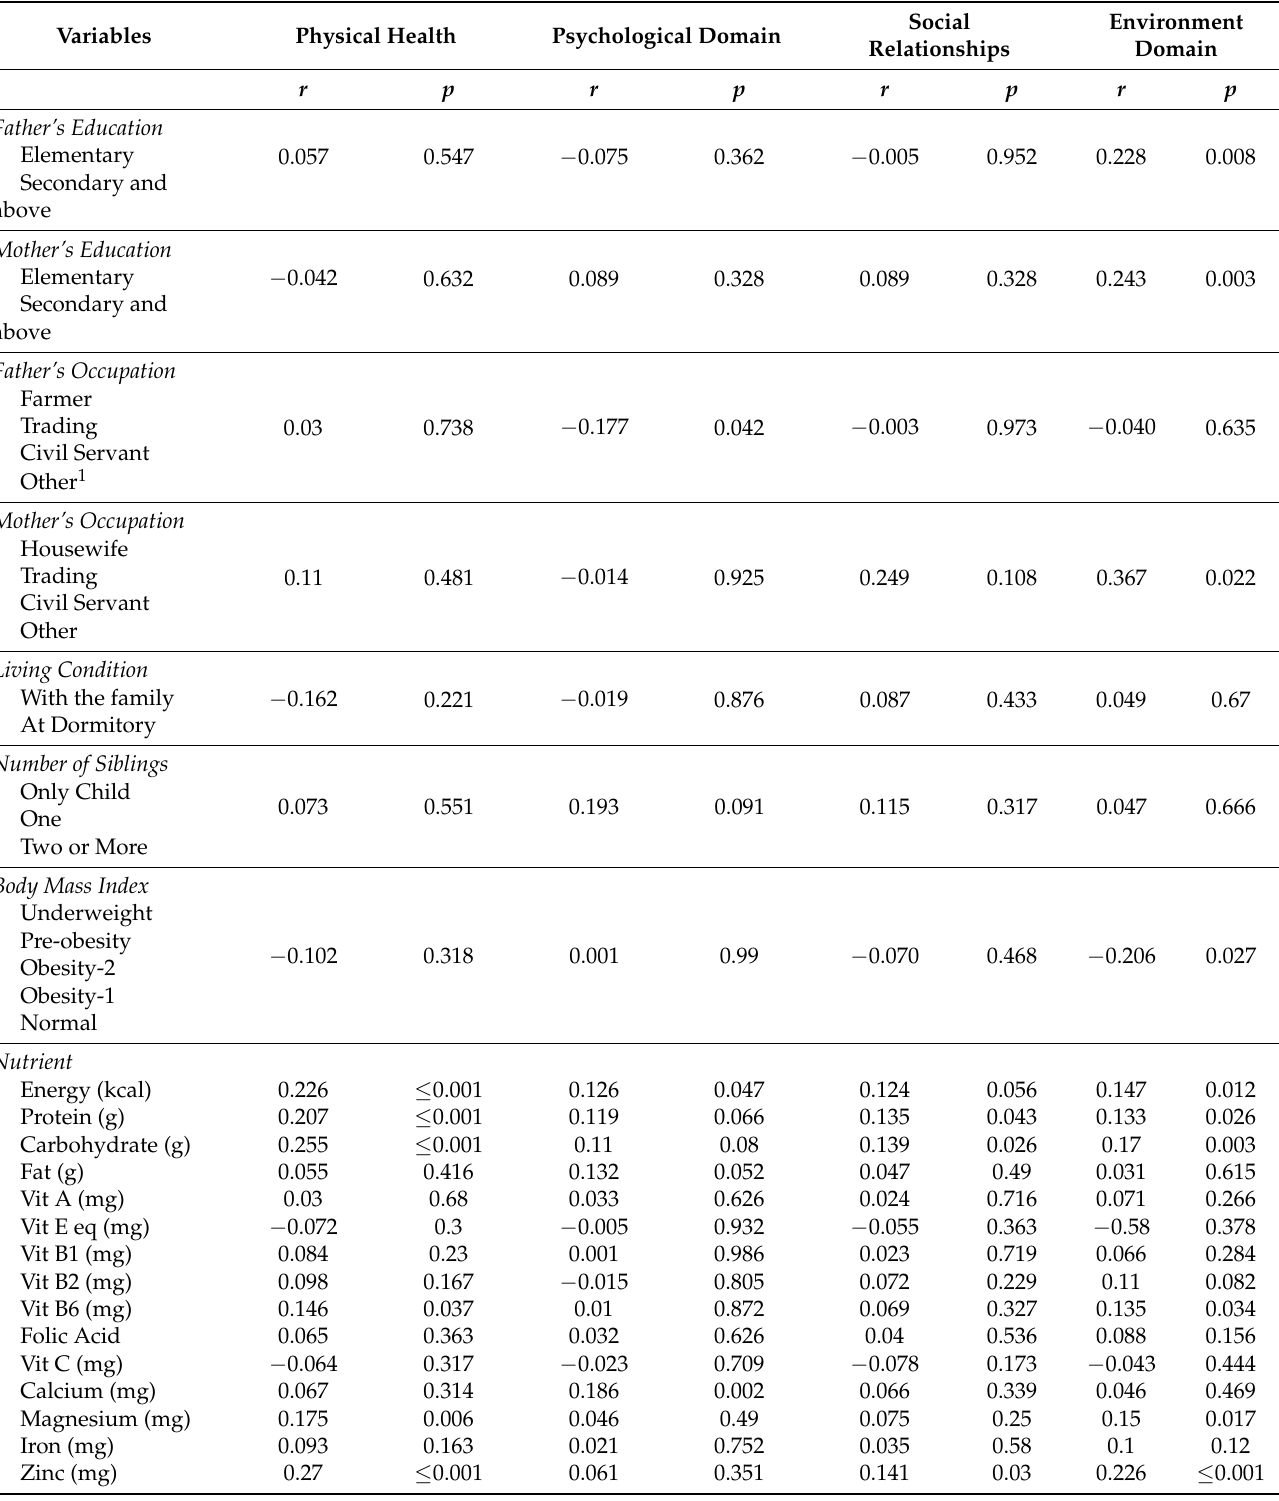
Table 3. Correlation of sociodemographic variables, nutritional status, nutrient intake, and their association with the QoL among adolescent